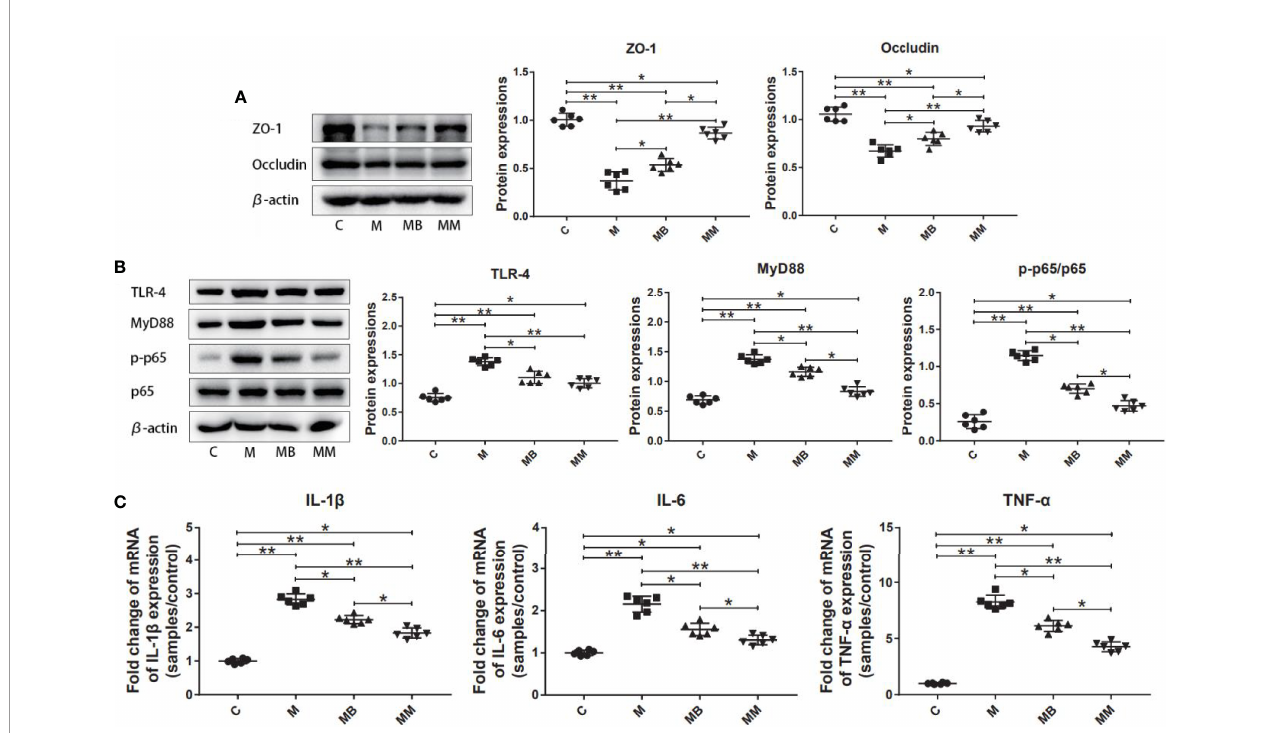
FIGURE 2 | BefA protein reduced intestinal in fl ammation and improved intestinal permeability. (A) Western blot analysis of ZO-1 and Occludin expression in colon tissues (n = 6), b -actin was used as an internal control. The relative expressions of ZO-1 and Occludin were quanti fi ed by Image J. (B) Western blot analysis of TLR-4, MyD88, p-p65 and p65 expression in colon tissues (n = 6), b -actin was used as an internal control. The relative expressions of TLR-4, MyD88, p-p65 and p65 were quanti fi ed by Image J. (C) Pro-in fl ammatory cytokines IL-1 b , IL-6 and TNF- a were detected in colon tissues at gene level by q-PCR (n = 6). Data are presented as means ± SD. One way repeated-measures ANOVA with Tukey ’ s test for multiple comparisons ( A – C , respectively); * p < 0.05, ** p <